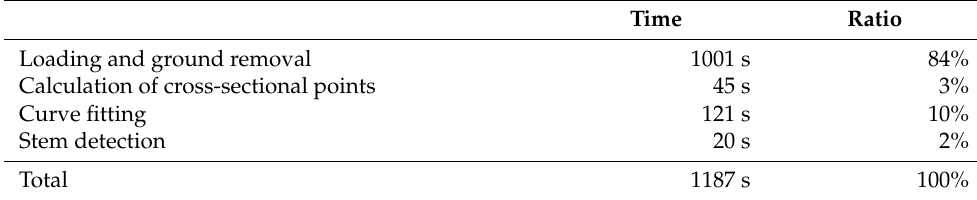
Table 5. Timing for stem detection from Dataset A using 10-cm intervals.